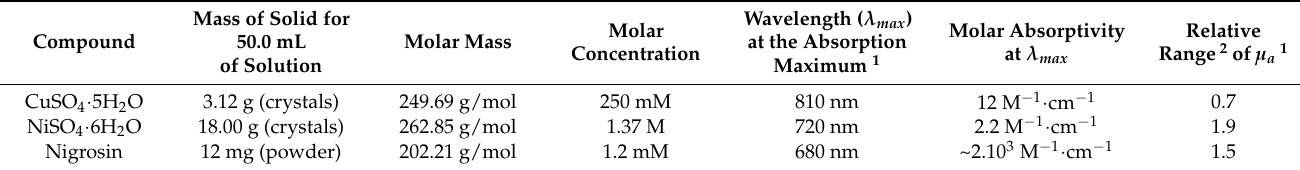
Table 2. Parameters for the stock